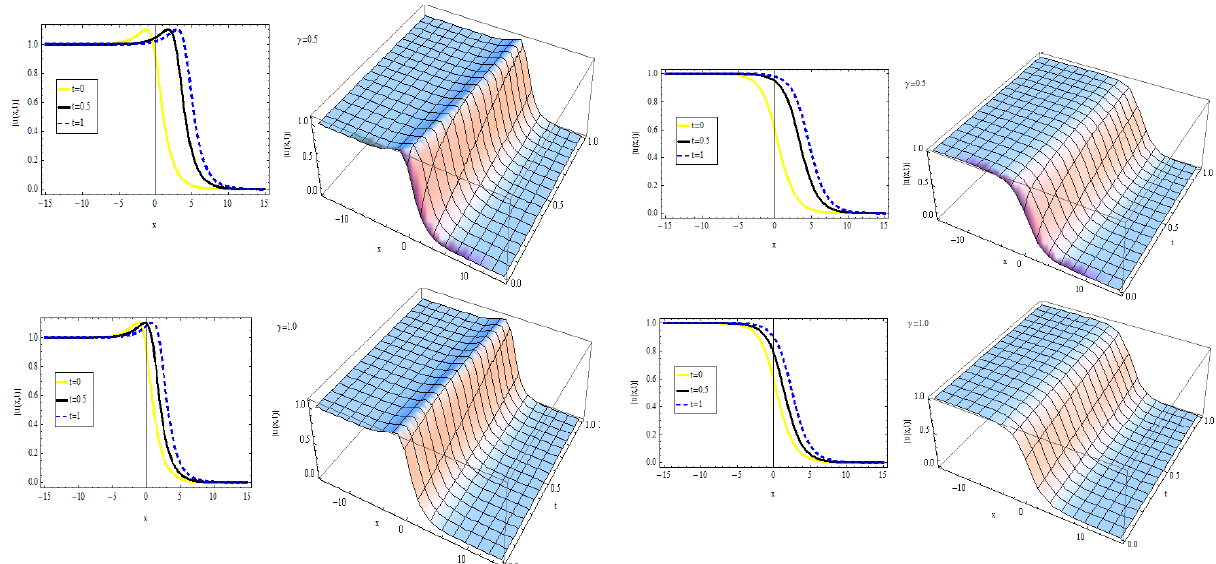
Figure 9: Graphs of (50) for conformable time-fractional Cahn-Allen